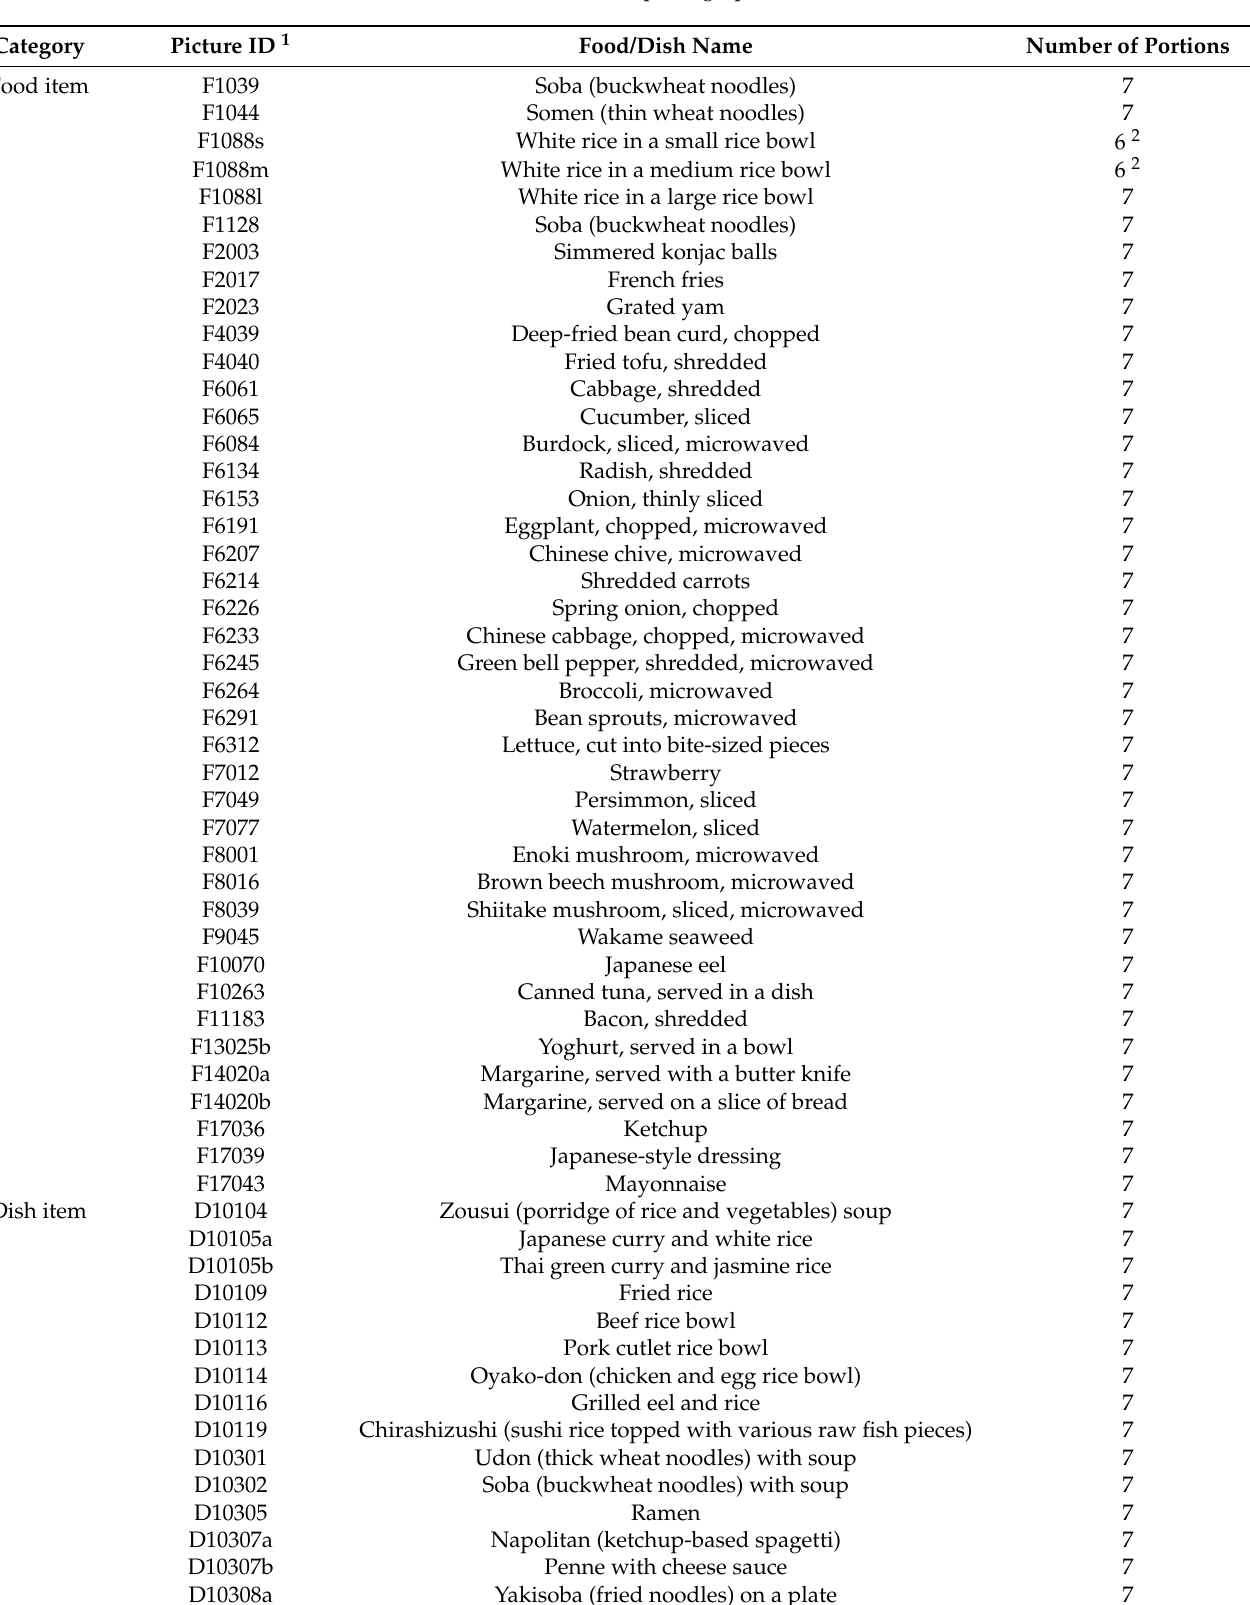
Table 1. List of items in the series of photographs ( n =